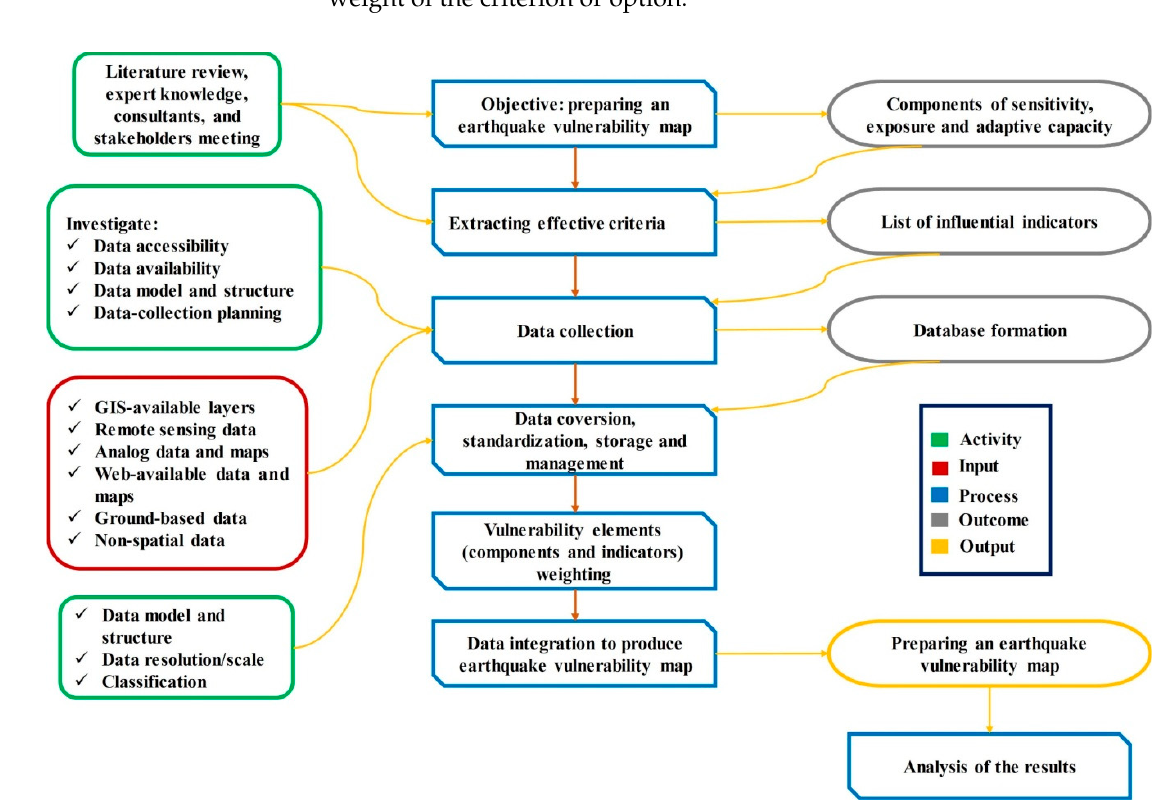
Figure 3. Flow diagram of study methodology.